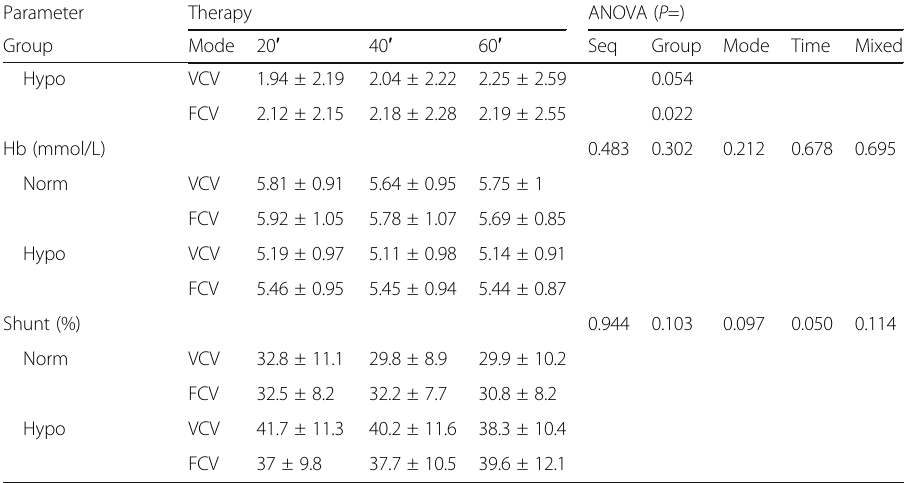
Table 1 Gas exchange and haemodynamics